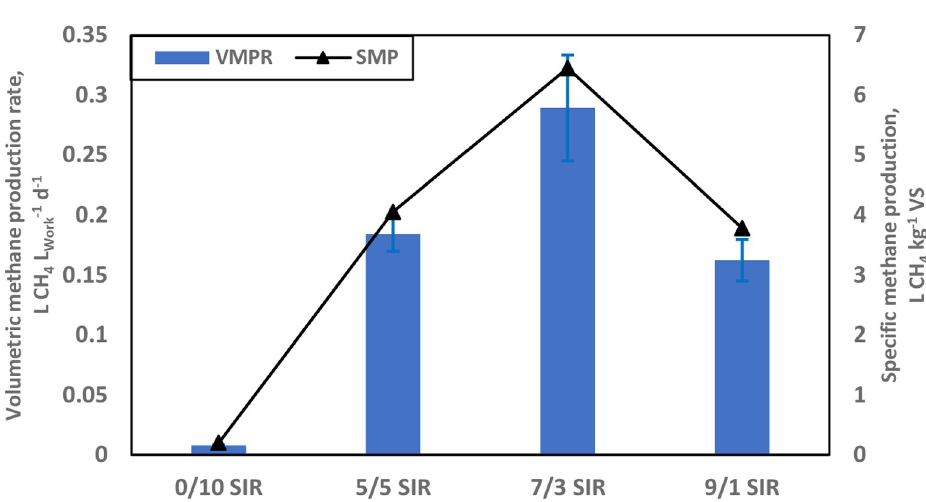
Fig 3. Experimental volumetric methane production rate (VMPR, L CH 4 LWork-1 d -1 ) and the cumulative specific methane production (SMP, L CH 4 kg -1 VS) from digestion setups with grape marc and cheese whey as mixed substrate (S) at different substrate-to-inoculum (S/I) ratios over 58 days of SS-AD. Data are presented as averages with standard